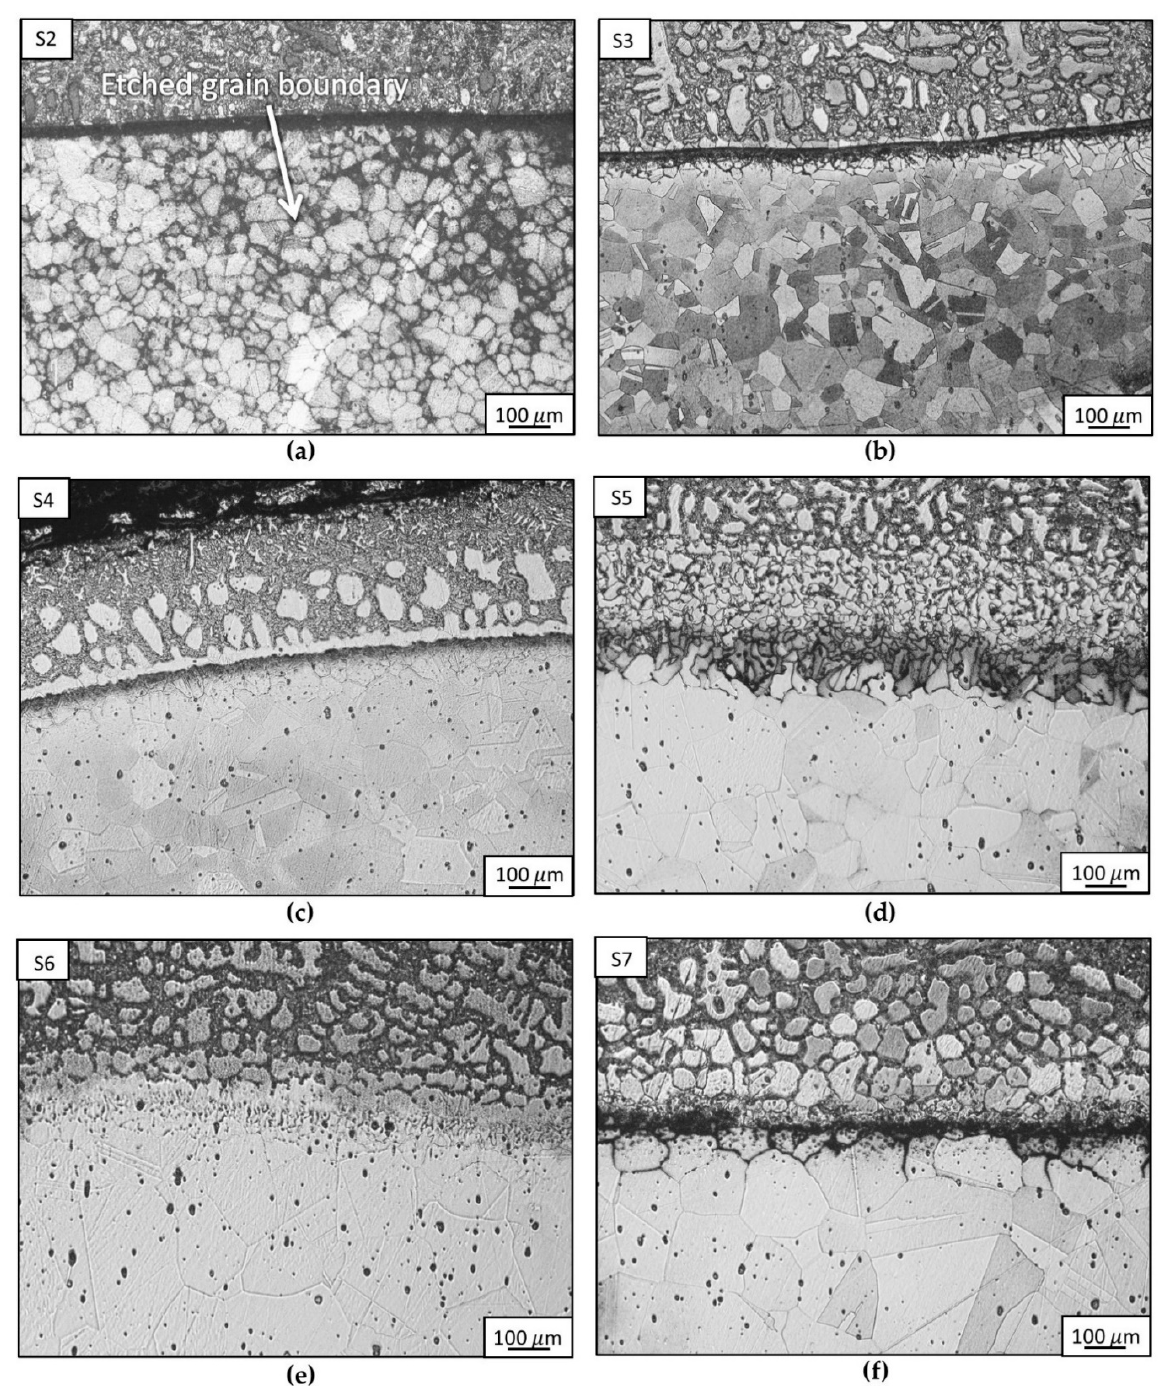
Figure 5. Etched substrate revealing the grain boundaries of the specimens: ( a ) 1050 °C for 2 min; ( b ) 1050 °C for 10 min; ( c ) 1050 °C for 20 min; ( d ) 1150 °C for 2 min; ( e ) 1150 °C or 10 min; ( f ) 1150 °C for 20 min.